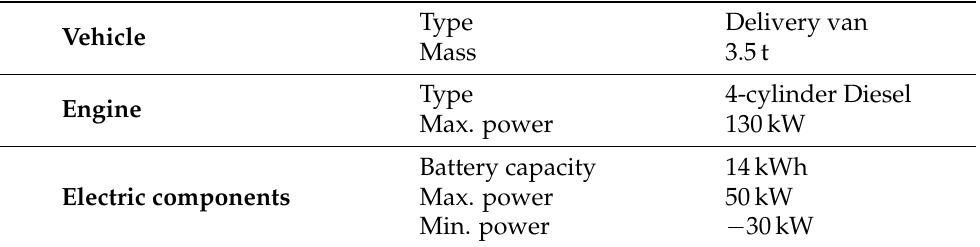
Table A1. Powertrain